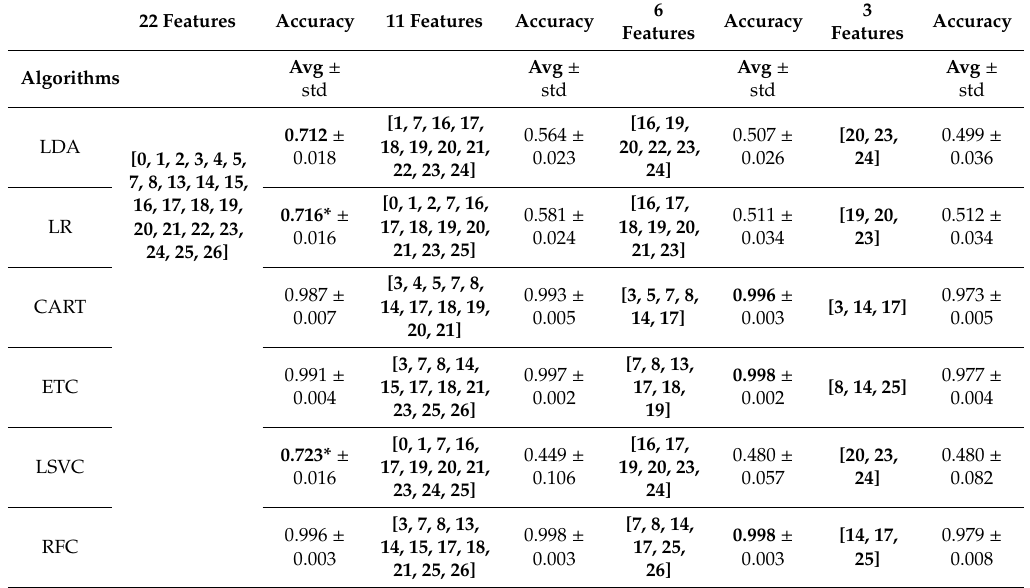
Table 5. Recursive Feature Elimination for R scenario. The feature numbers are the same as those in Table 4, which are reported here for your convenience: 0 : Z-axis acceleration; 1 : Y-axis